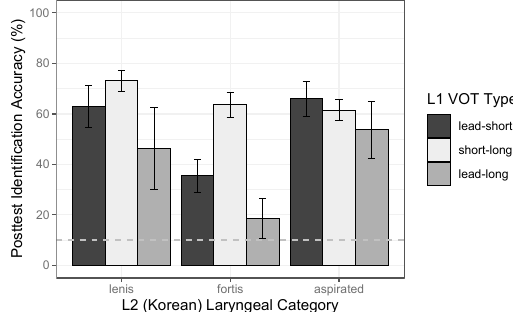
Figure 4. Posttest performance in the stop study (accuracy in 10AFC identification), by L2 laryngeal category and L1 group (i.e., VOT type). Error bars indicate SE of the mean over participants; the dotted line marks chance ‐ level performance (10%).